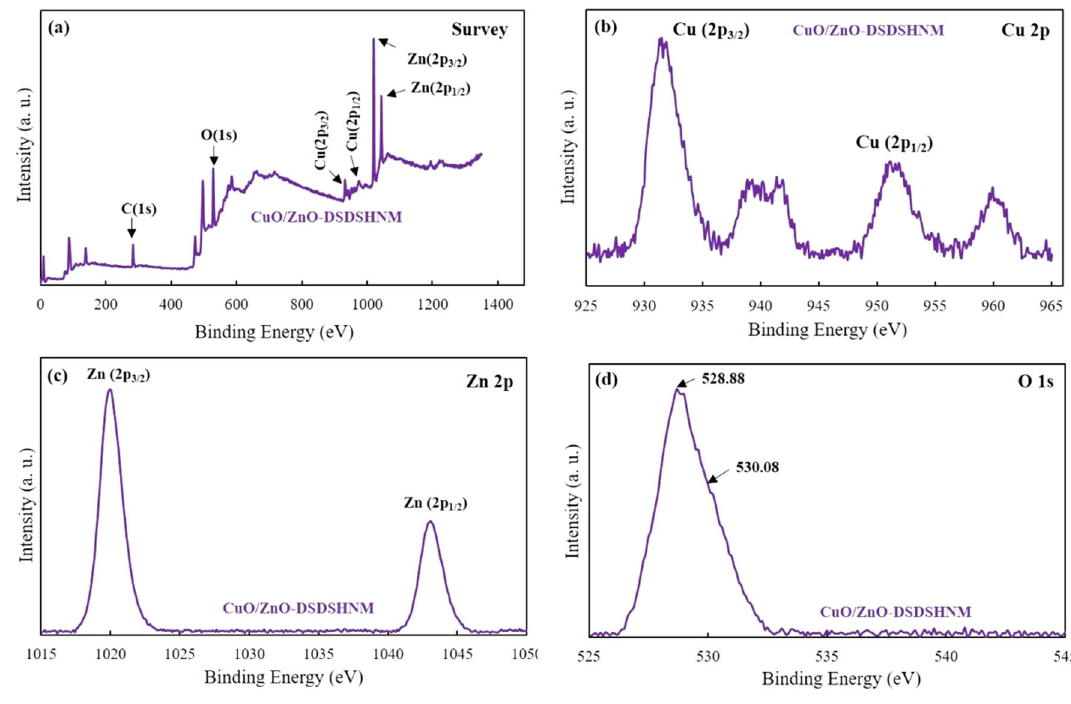
Figure 5. XPS spectra of CuO/ZnO-DSDSHNM showing full scan survey ( a ) and corresponding peaks in the high-resolution spectra for Cu 2p ( b ), Zn 2p ( c ), and O 1 s ( d ).